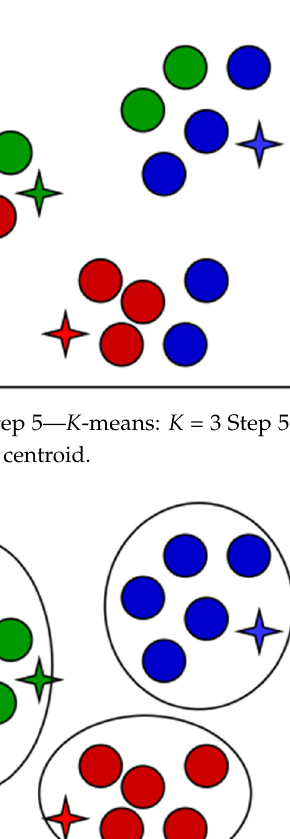
Figure 6. Step 3— K ‐ means: K = 3 Step 3: Group data point to their nearest centroid by measuring